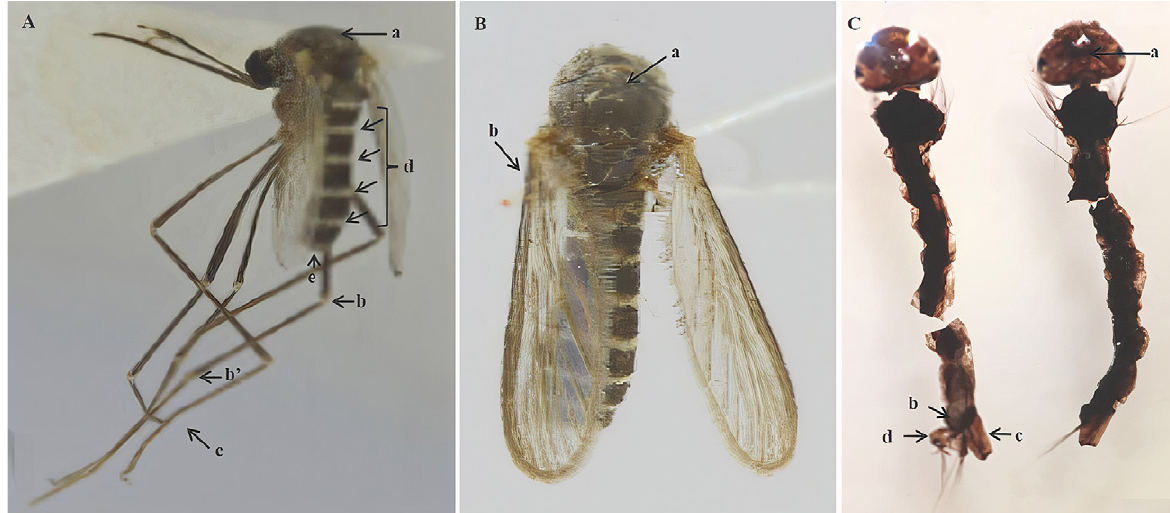
Figure 2. Aedes ( Ochlerotatus ) lepidus . A, B. Female: ( A ) lateral view: ( a ) thorax: integument brown dark; ( b ) hind femurs ( b ′ ) hind tibia with a ring of pale scales at the apex; ( c ) tarsi dark-scaled; ( d ) abdomen: abdominal terga usually with basal pale bands; ( e ) narrow and retractable abdominal segment VIII, not visible on external examination; ( B ) dorsal view: thorax: ( a ) scutum covered with patches of pale scales; ( b ) wing dark-scaled. C. Larva: ( a ) head (dorsal view): 5-7-C setae, or at least 7-C varying between doubles, triples and multiples; ( b ) abdominal segment VIII: pecten arranged in a single row and regularly spaced from each other, the scales of pecten have chitinized teeth, bilateral, enlarged from the base to the apex; ( c ) siphon: seta 1-S multiple and inserted beyond siphonal pecten; ( d ) segment X with incomplete saddle.